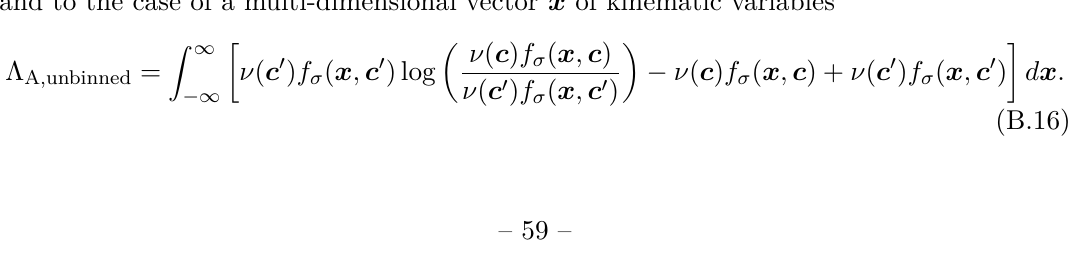
| c ) , indicating that the c and q wald , meaning that c c